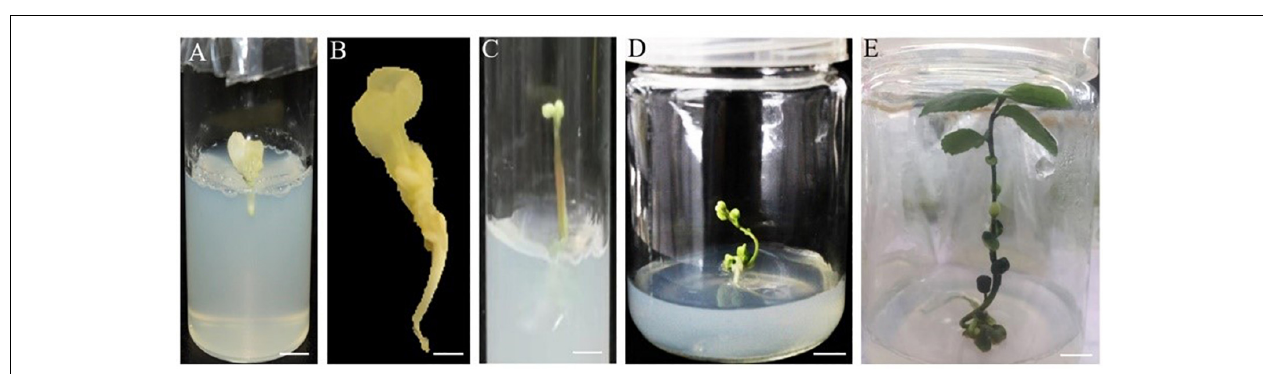
FIGURE 6 | Plantlet regeneration in direct and indirect somatic embryogenesis of C. oleifera . (A,B) Regenerated roots 110–115 days after inoculation in indirect somatic embryogenesis. (C) Regenerated shoots 90 days after inoculation in direct somatic embryogenesis. (D,E) Plantlet with shoots and roots ready for acclimatization 120–130 days after inoculation. Bars: (A,C,D,E) = 1 mm and (B) = 0.5 mm.